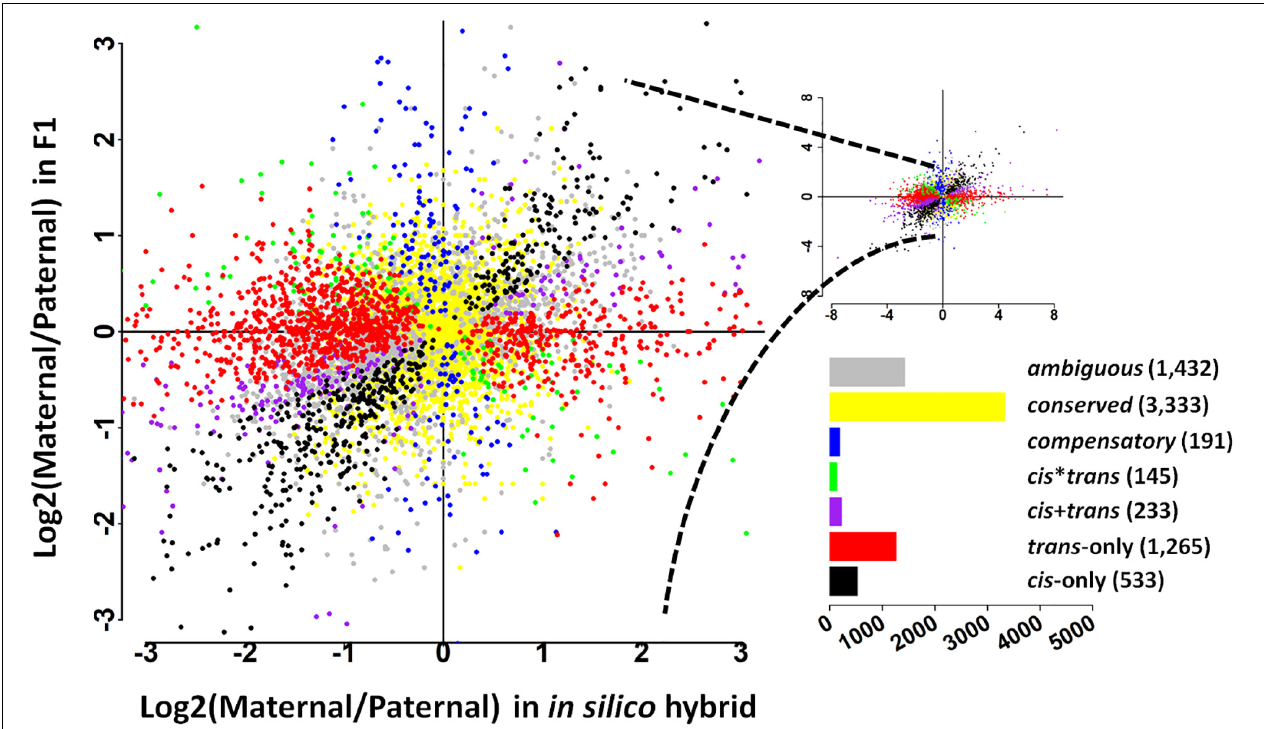
FIGURE 1 | Plot summarizes the relative, allele-specific expression levels in parental ( in silico hybrid) and the F1 hybrids. Each gene is shown as a point which is color-coded according to the pattern of regulatory divergence. The bar graph depicts the total number of genes in each pattern.